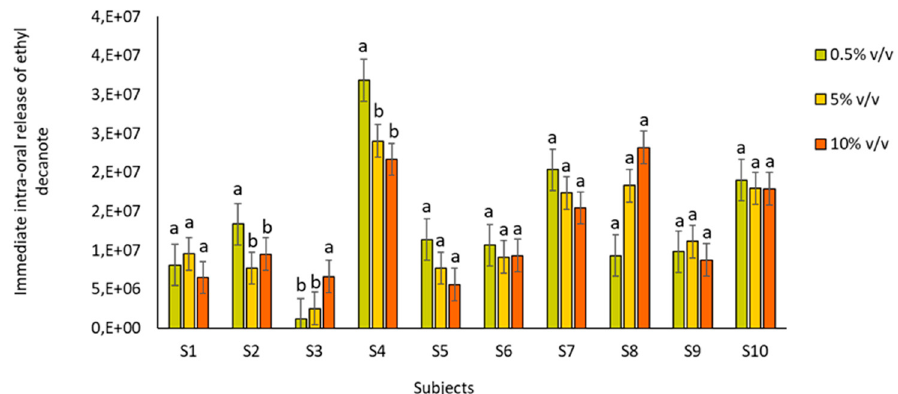
Figure 3. Immediate oral ethyl decanoate release (absolute peak areas) obtained for the volunteers (n = 10) after rinsing their mouths with the wines. Different letters across the different compounds denote statistical differences (p value < 0.05) after the application of the Tukey test for means comparison.